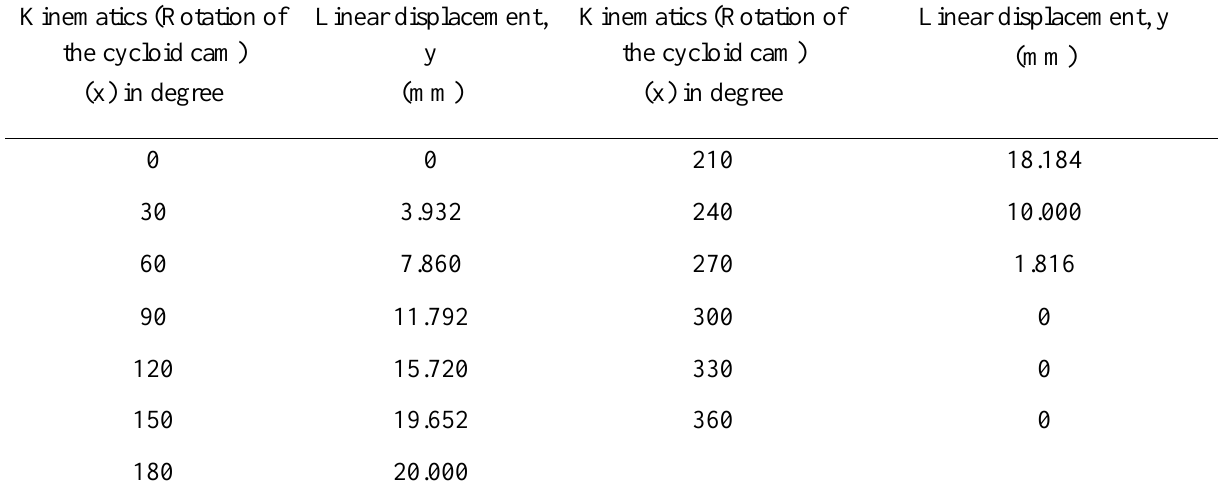
Table 7. The theoretical displacement of the cam from the circumference of the base circle to its profile (the kinematic motion of the follower during the rotation of the cycloid cam) for the big cam size of maximum displacement (H), 20 mm from the base circle of the cam